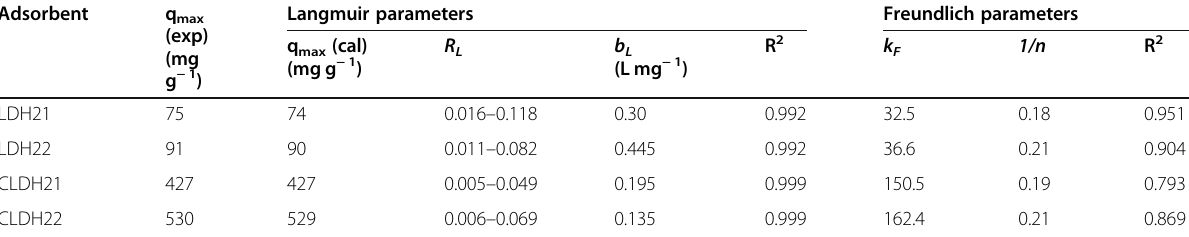
Table 4 Langmuir and Freundlich ’ s parameters for IDB adsorption onto LDHs and CLDHs adsorbent Langmuir Adsorbent q max (exp)